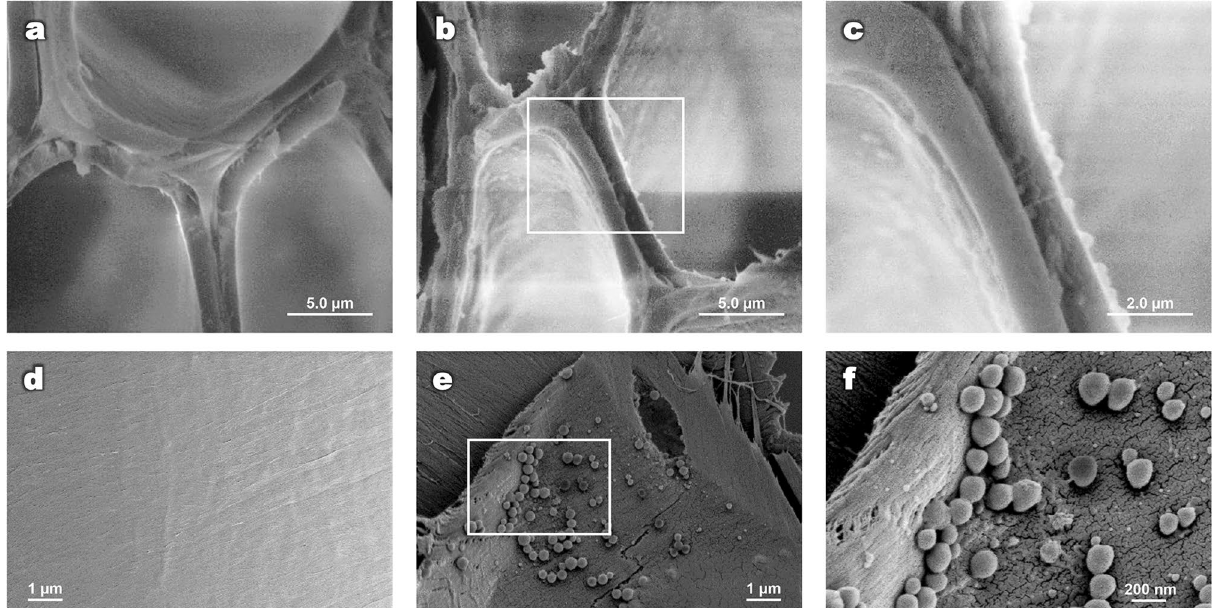
Figure 4. SEM ( a – c ) and FEG-SEM ( d – f ) images of poplar cell walls. Images before hydrothermal treatment ( a , d ). Images after 40 min of hydrothermal treatment at 180 °C ( b – e ). The regions within the white rectangles are shown in ( c , f ) at increased magnification. It is possible to observe cell wall detachment and the formation of round